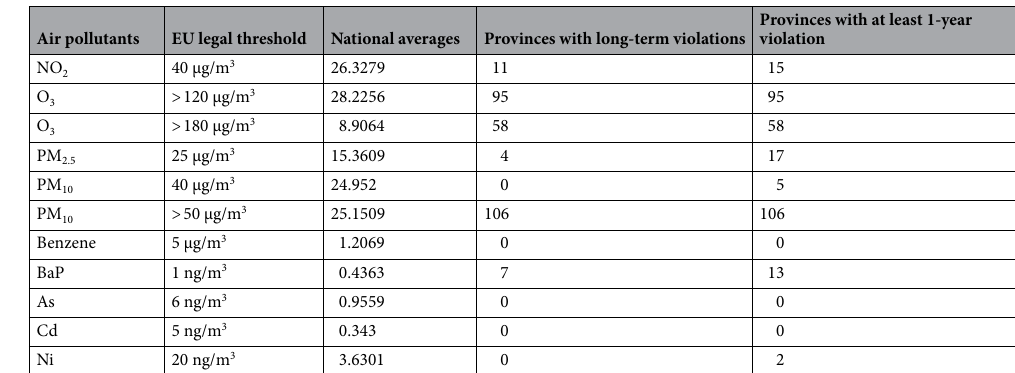
Table 2. Provinces that exceeded the EU legal threshold in the period 2014–2019. Source: European Commission 45 .